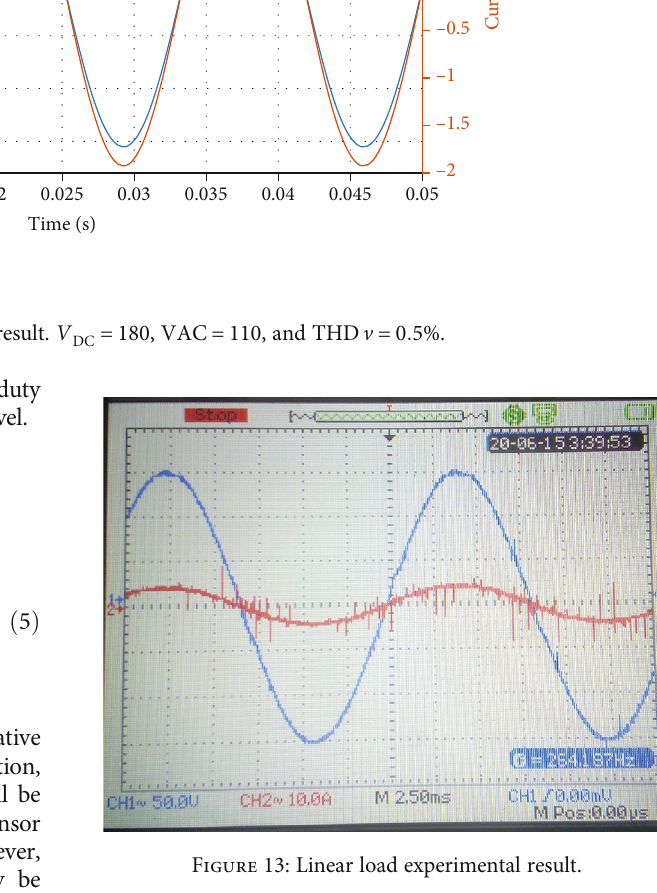
Figure 13: Linear load experimental